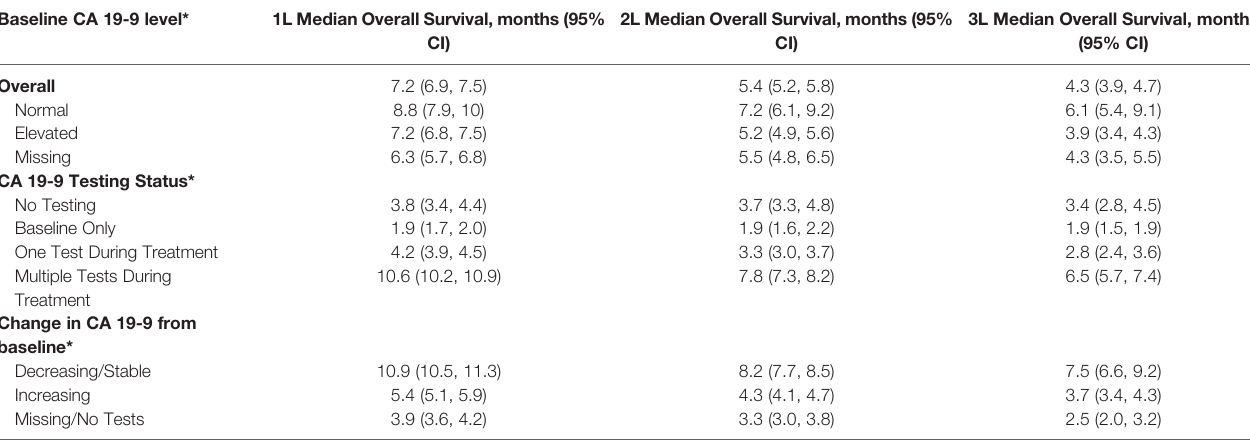
TABLE 3 | Overall survival by CA 19-9 baseline value, testing frequency, and trends. Baseline CA 19-9